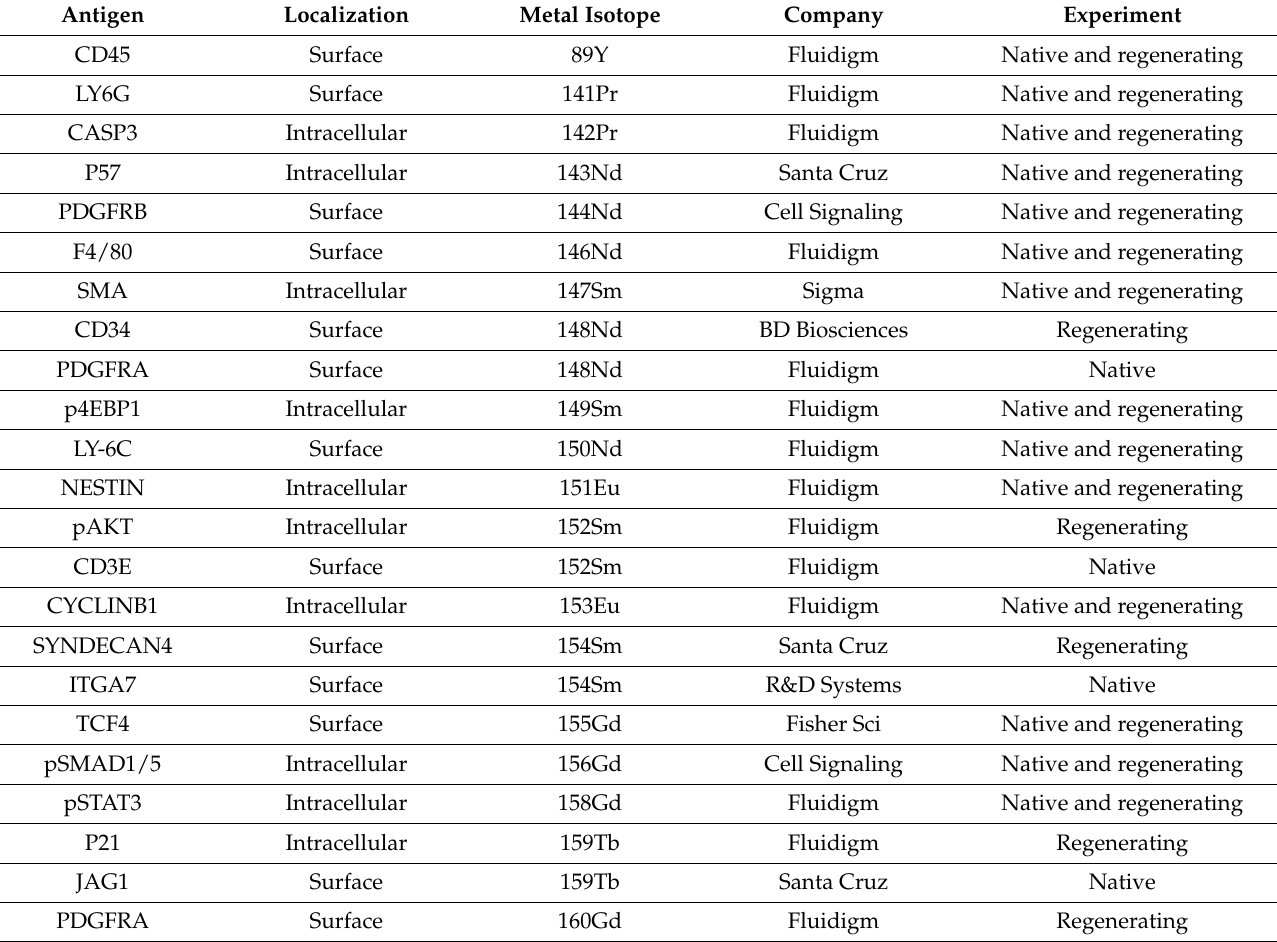
Table 1. List of Antibodies Used in CyTOF